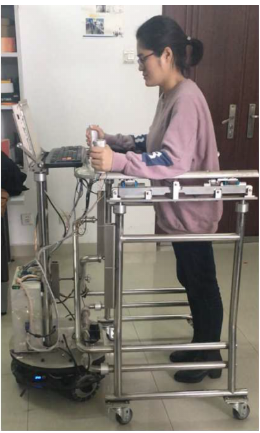
Figure 13. Walker frame based walking assistants (WWA)—the walking-aid robot